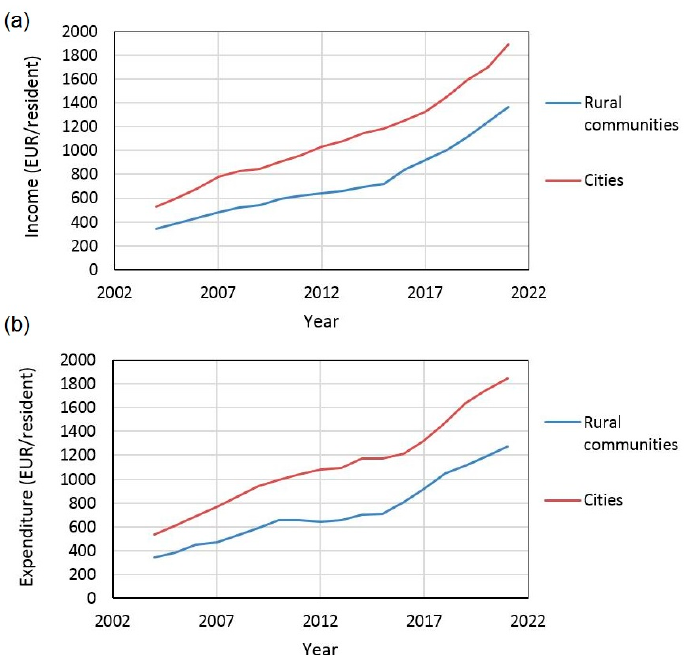
Figure 21. Rural and urban communities economics in 2004–2021, data obtained from [66]: ( a ) communities incomes per 1 resident, ( b ) communities expenditures per 1 resident.